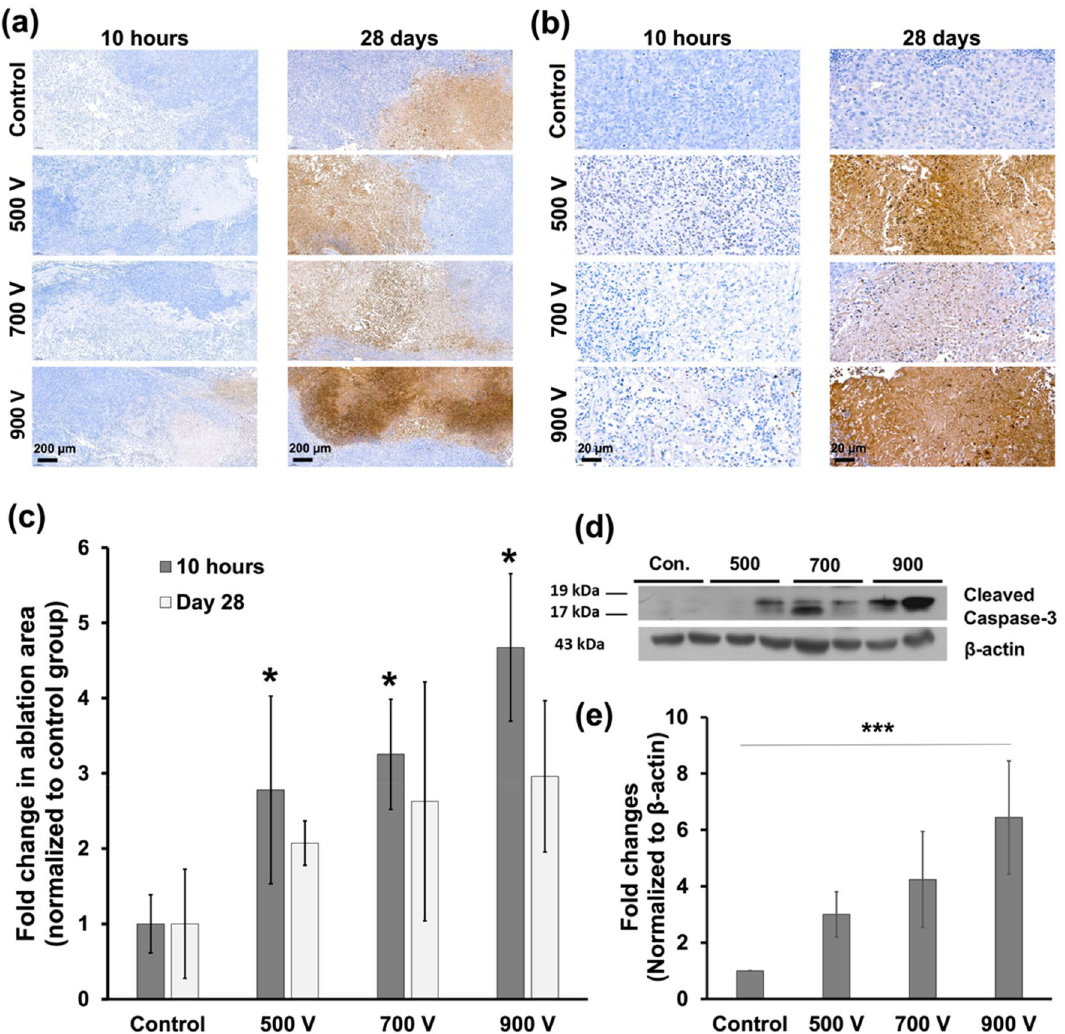
Figure 4. Representative terminal deoxynucleotidyl transferase-mediated dUTP nick and labeling (TUNEL)- stained images and western blot findings at different applied voltages. ( a – b ) TUNEL-stained images showing the boundary between non-IRE-treated and IRE-treated regions at ( a ) 10 h and 28 days and ( b ) magnified views. ( c ) The ablation area became proportionally larger as the applied voltage increased. Within the same group, the ablation area at 28 days was smaller than that at 10 h. ( d ) The cleaved caspase-3 band was not detected in the control group and could be seen in the other three groups with an increasingly prominent tendency as the applied voltage increased. ( e ) The expression of cleaved caspase-3 bands showed an approximately 3-, 4.2-, and 6.4-fold increase in the 500, 700, and 900 V groups, respectively, compared to the control